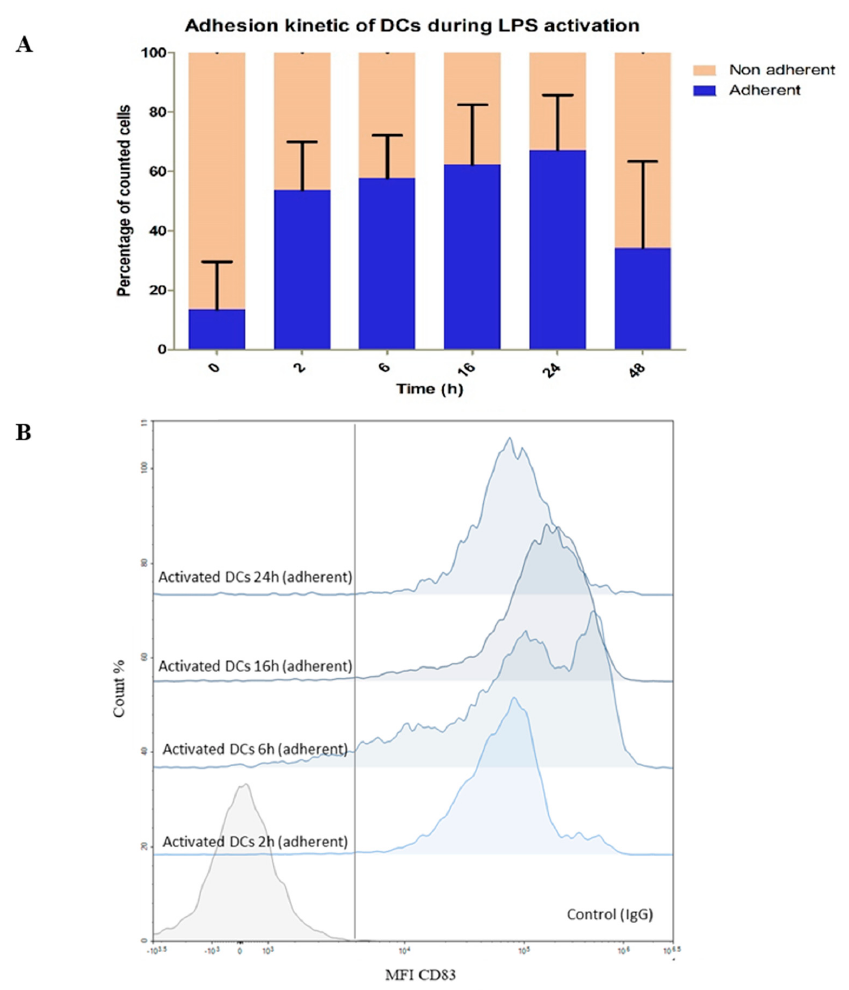
Figure 4. Kinetic experiment over 48 h of LPS − DC activation. 0 h: without LPS; 2, 6, 16, 24, 48 h: exposure time to LPS at 1 µg mL − 1 . ( A ) Bar graphs showing the evolution of the proportion of the DC state (non-adherent to adherent) over time in the culture medium (orange) or attached to the flask (blue). ( B ) Evolution of the surface marker CD83 over time on adherent DC population by flow cytometry analyses. The vertical gray line represents the separation between the negative and positive gates according to the intensity of the IgG anti-mouse control. MFI: Mean Fluorescent Intensity.